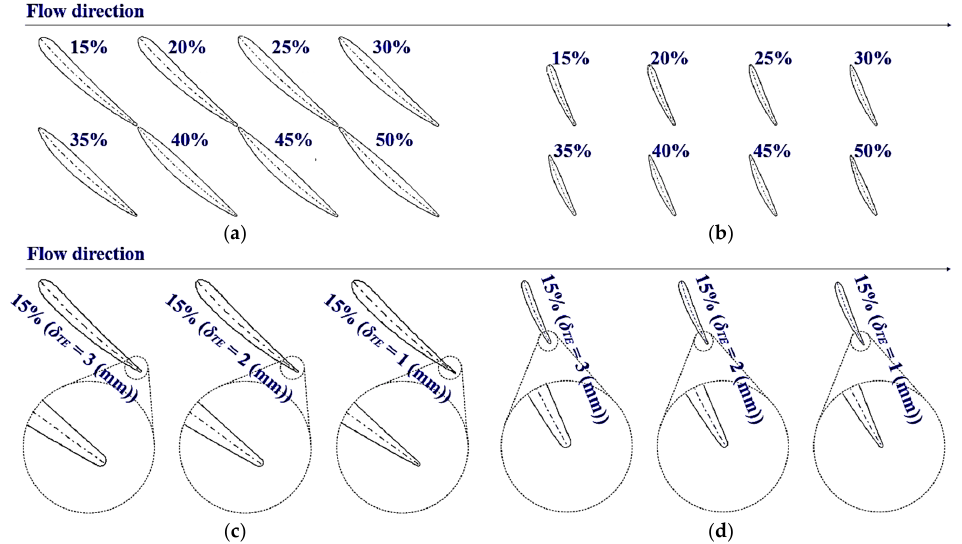
Figure 4. Sectional shapes of the airfoil for the maximum thickness position at the ( a ) hub and ( b ) shroud span, and the thickness treatment near the trailing edge at the ( c ) hub and ( d ) shroud span.